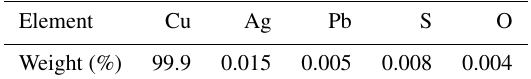
Table 2. Chemical composition of electrode. Element Cu Ag Pb S O Weight (%) 99.9 0.015 0.005 0.008